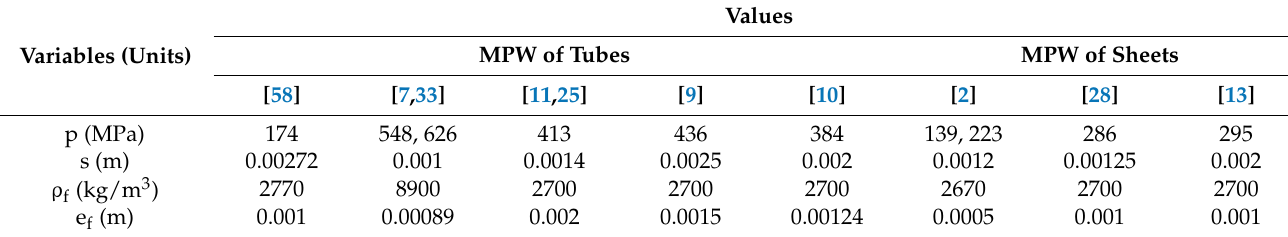
Table 7. Values used for calculation of the flyer impact velocity (v i ).